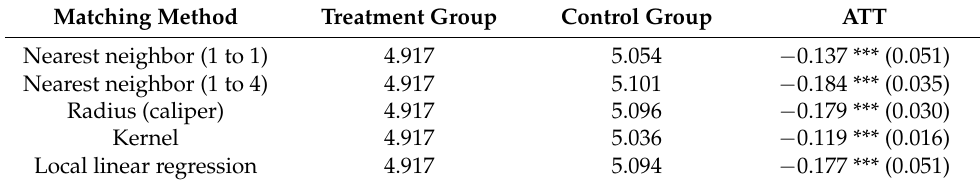
Table 4. Results of PSM estimation.